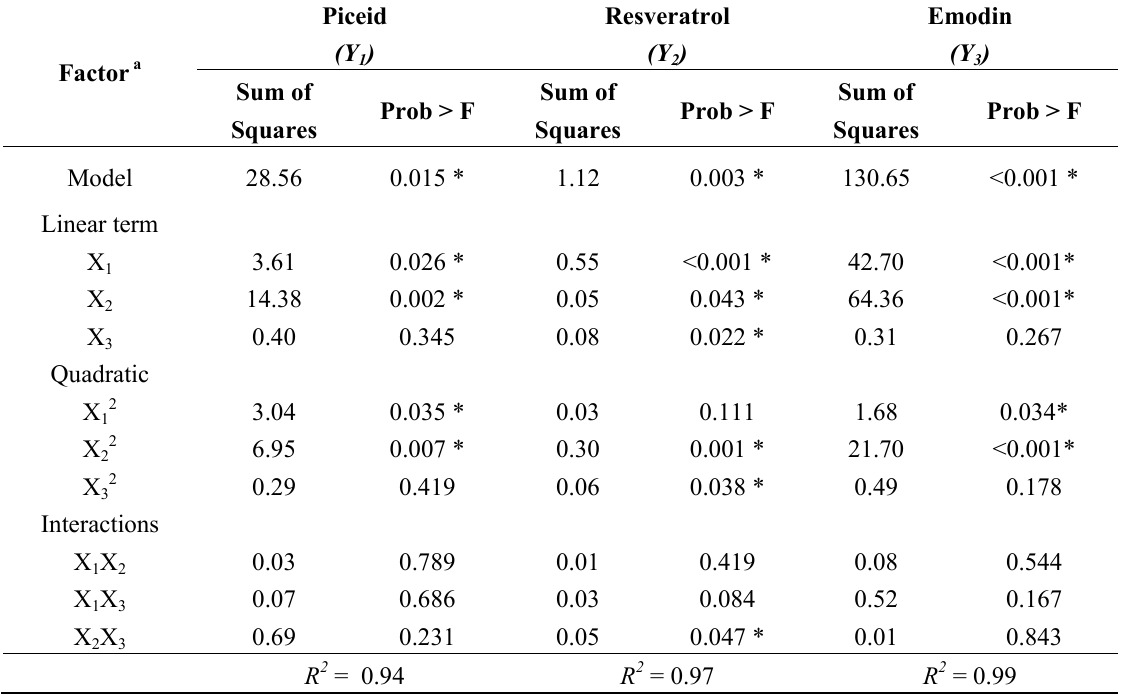
Table 2. ANOVA for response surface models of all independent